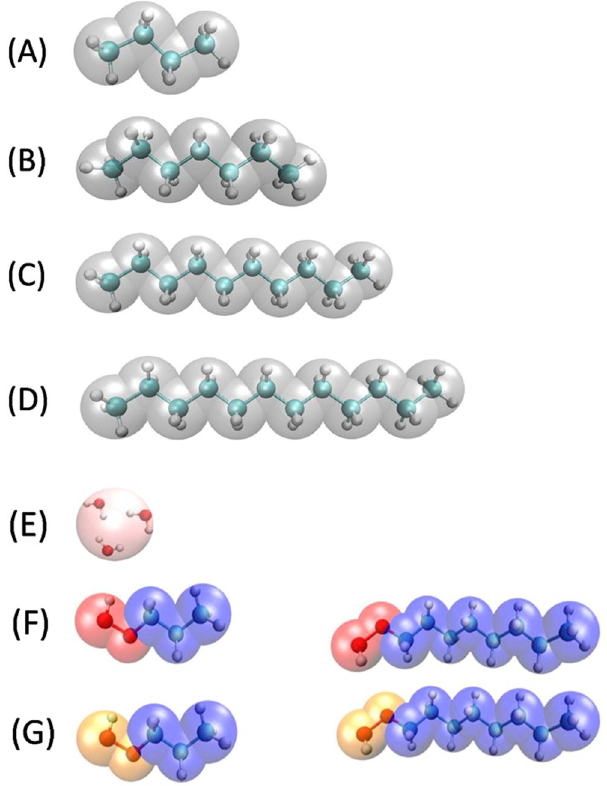
Figure 1. Schematic representation of the coarse-grained models adopted in this work. ( A ) Butane model; it is mapped into a four – bead linear molecule of identical DPD beads. ( B ) Model for the heptane molecule. ( C ) Decane molecule model. ( D ) Dodecane molecule model. ( E ) Water DPD model. ( F ) Models for non-ionic surfactants. The five – bead chain is shown on the left, and on the right is the ten – bead surfactant. The red beads (left end of the molecules) represent the hydrophilic head and blue beads correspond to the hydrophobic tail. ( G ) DPD models for ionic surfactants, which are of the same length as their nonionic counterparts. The yellow beads (left end of the molecules) represent the hydrophilic head and blue beads correspond to the hydrophobic tail. These figures were prepared with VMD 49